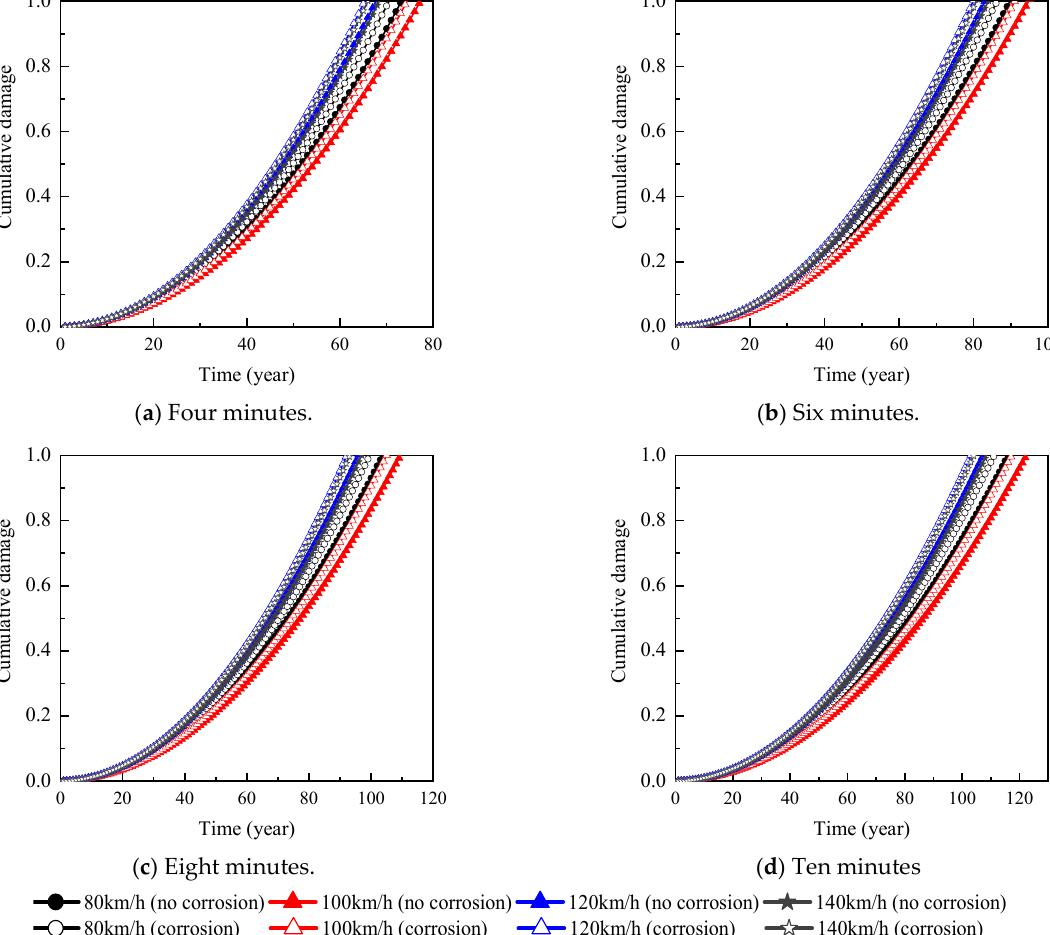
Figure 9. The cumulative damage of 30 m-span bridge.